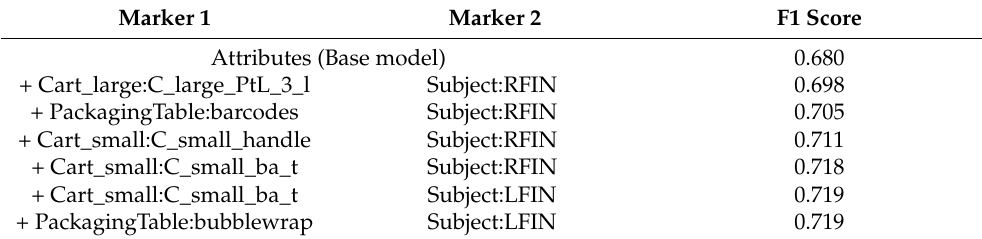
Table 6. Greedy feature selection results (QDA, distance features).